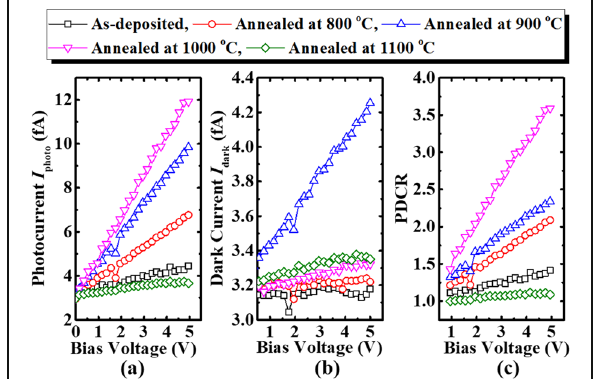
Fig. 7 a I photo - V bias , b I dark - V bias , and c PDCR characteristics of the as- deposited poly-(Al